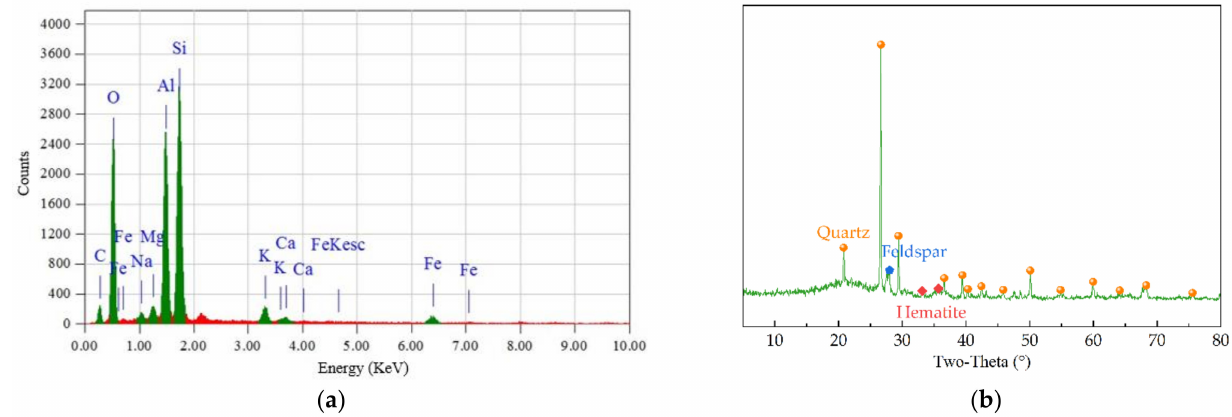
Figure 1. Properties of RCB aggregate: ( a ) EDS spectrum; ( b ) XRD pattern.